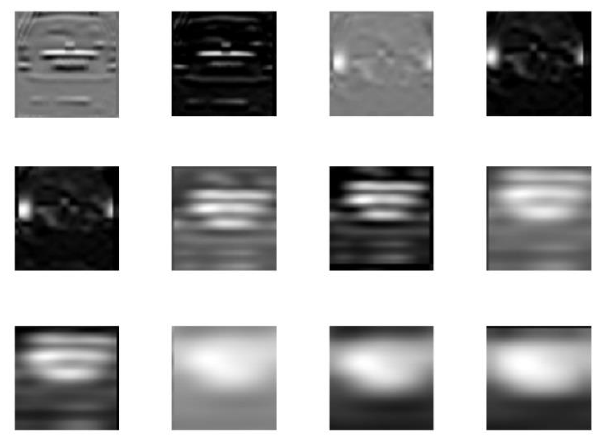
Figure 7. Maximum value feature maps in each CNN layer.